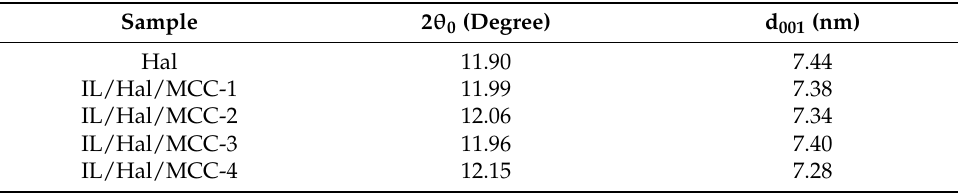
Table 1. XRD data of IL/Hal/MCC ionogel